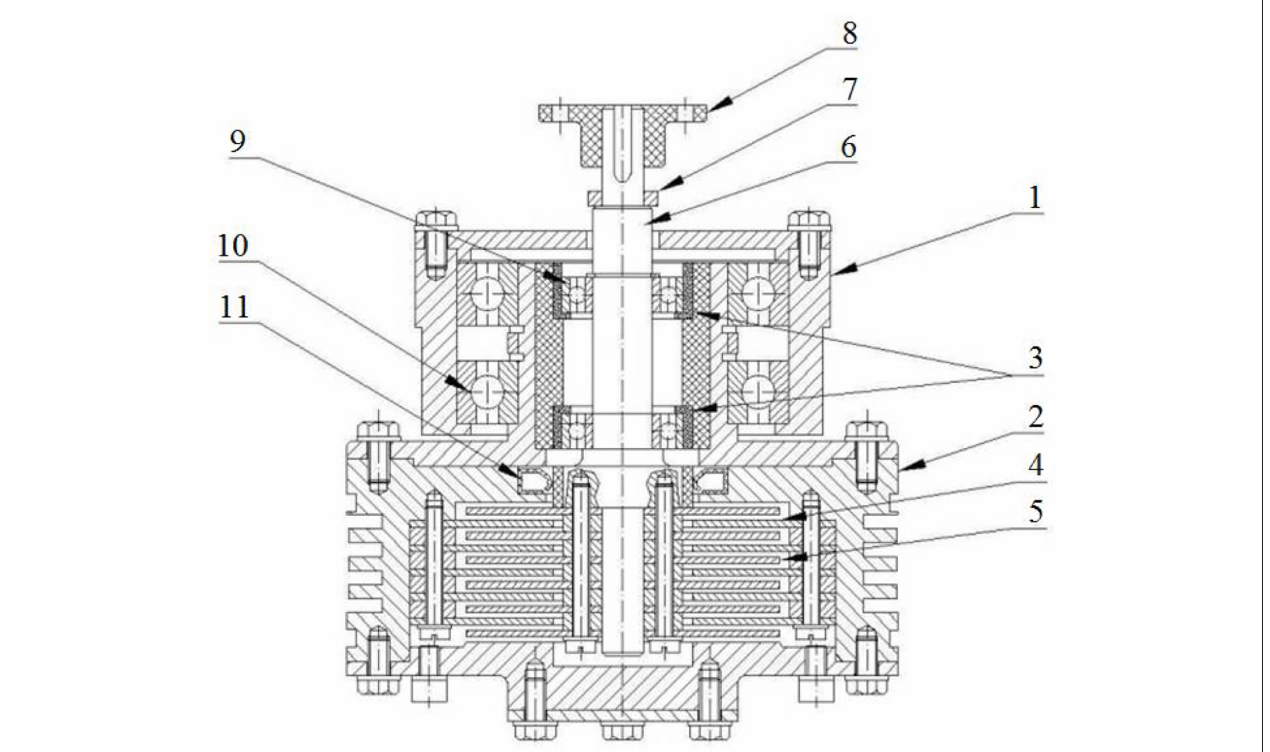
FIGURE 7 | Design solution of a prototype of the clutch: 1, bearings casing; 2, clutch casing; 3, insulating sleeves for shaft bearings; 4, discs fixed to the casing; 5, discs placed on the shaft; 6, shaft; 7, sliding ring; 8, flexible coupling; 9, shaft’s bearing; 10, clutch’s bearing; 11, sealing ring.